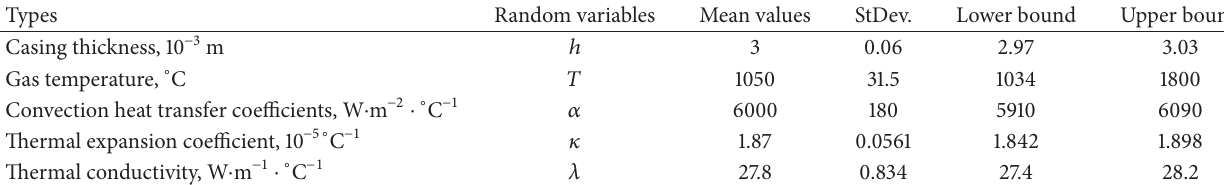
Table 2: Numerical characteristic of extremum random